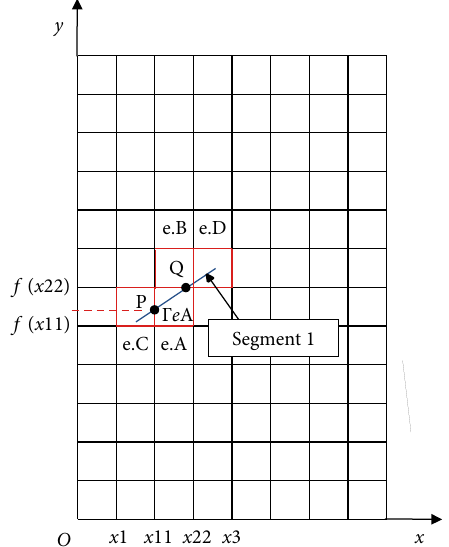
Figure 2: Searching for elements intersecting crack segment 1.